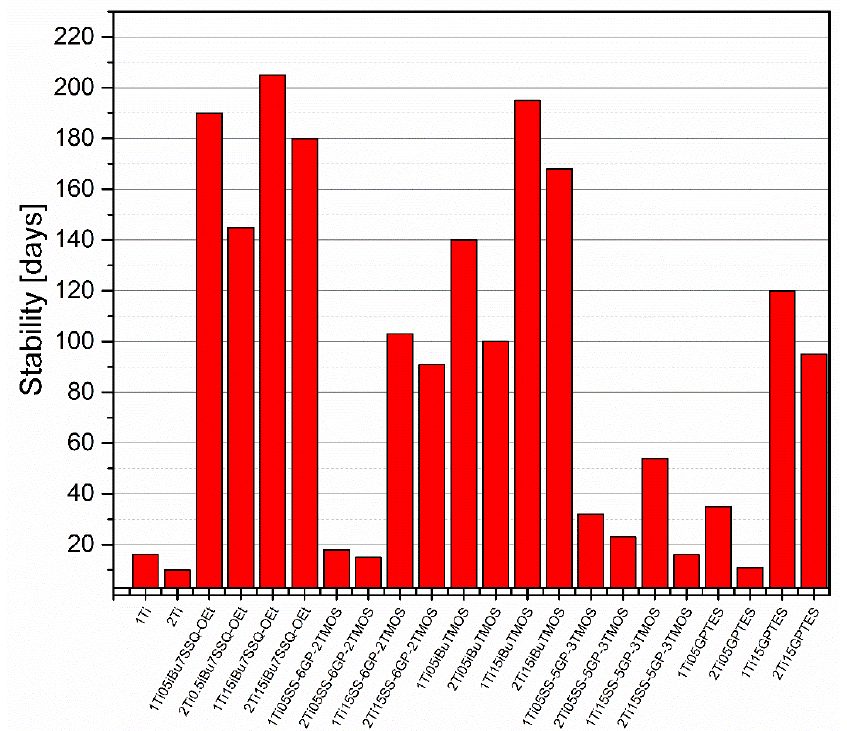
Figure 10. Time-dependent stability of TiO 2 suspensions in liquid epoxy systems prepared by pump mixing.